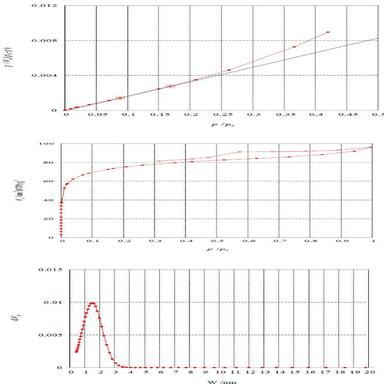
BET-plot (a), adsorption desorption isotherms (b) and pore size distribution (c) of SiO2@C nanocomposite (SC2).